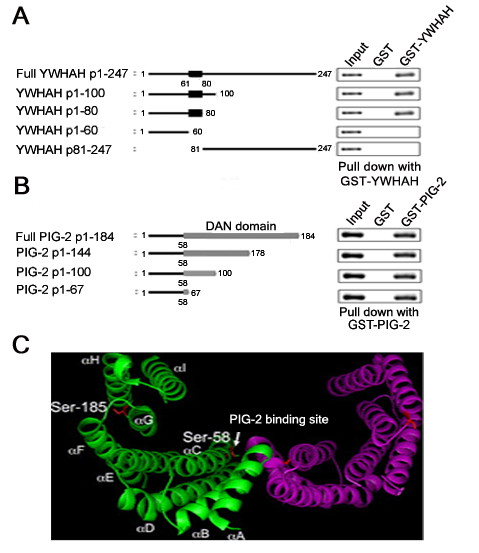
Association of PIG-2 and YWHAH. (A) Mapping of PIG-2 binding domain of YWHAH. Five GST fusion constructs, Full-YWHAHp1-247, YWHAHp1-100, YWHAHp1–80, YWHAHp1–60 and YWHAHp81–247 were prepared using YWHAH cDNA as a template DNA. The GST pull-down assay showed that Three GST-YWHAH constructs, Full-YWHAHp1–247, YWHAHp1–100 and YWHAHp1–80 bind YWHAH, but not YWHAHp1–60 and YWHAHp60–247. The YWHAH binding site for PIG-2 was delineated to be residues 61–80 (black box). (B) Mapping of YWHAH binding domain of PIG-2. Four GST fusion constructs, Full-PIG-2p1-184, PIG-2p1-144, PIG-2p1-100 and PIG-2p1-67 were prepared using PIG-2 cDNA as a template DNA. The GST pull-down assay showed all constructs, The PIG-2 binding site for YWHAH was delineated to be residues 1–67. Gray box is DAN domain. (C) Schematic diagram shows X-ray crystallography of YWHAH protein. PIG-2 protein binding site was indicated by arrow.